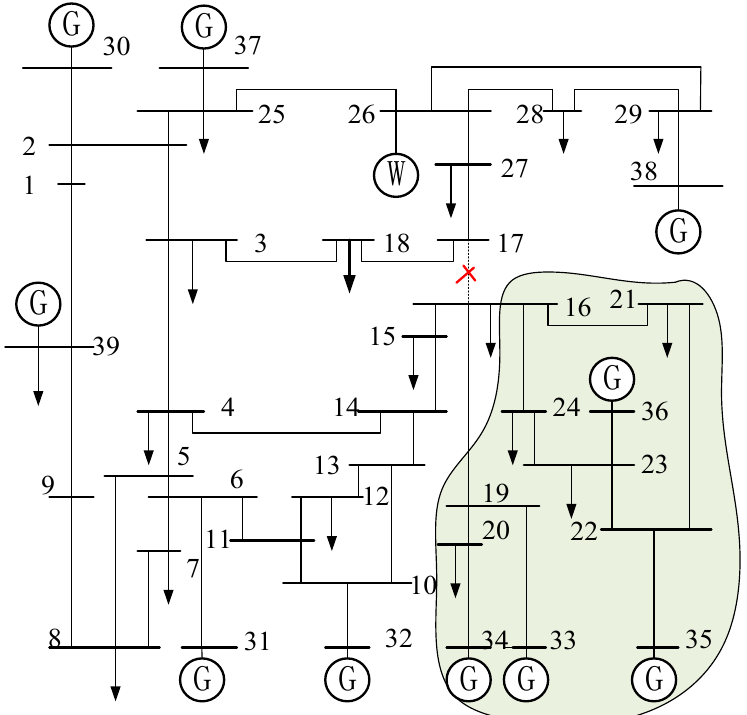
Figure 9. Schematic diagram of IEEE 39-node system. Table 3. Initial operating parameters of the generator. The optimal regulation model of closing angle is solved based on NSGA-II, and the cumulative time is 187 s. The obtained multiobjective Pareto solution is shown in Figure 10.